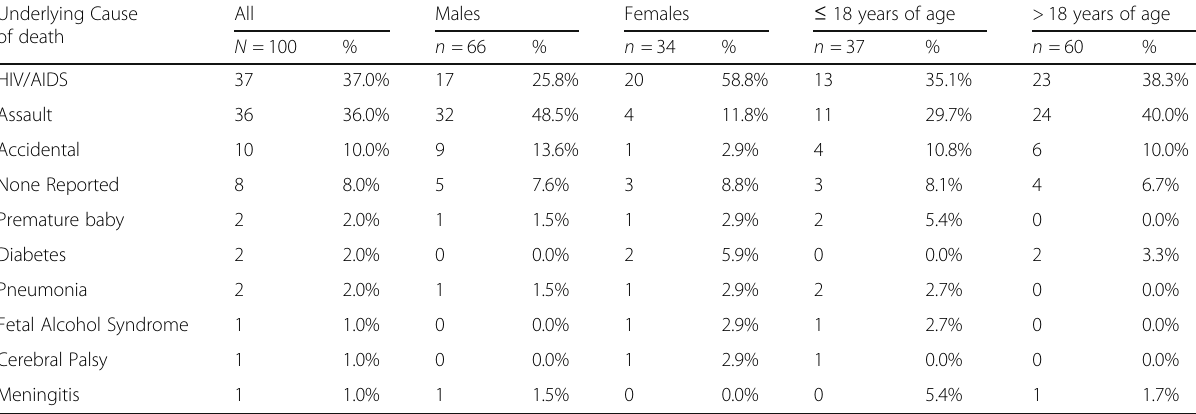
Table 2 Underlying cause of death by age and sex among street-connected young people in Eldoret Kenya 2009 – 2016 Underlying Cause of